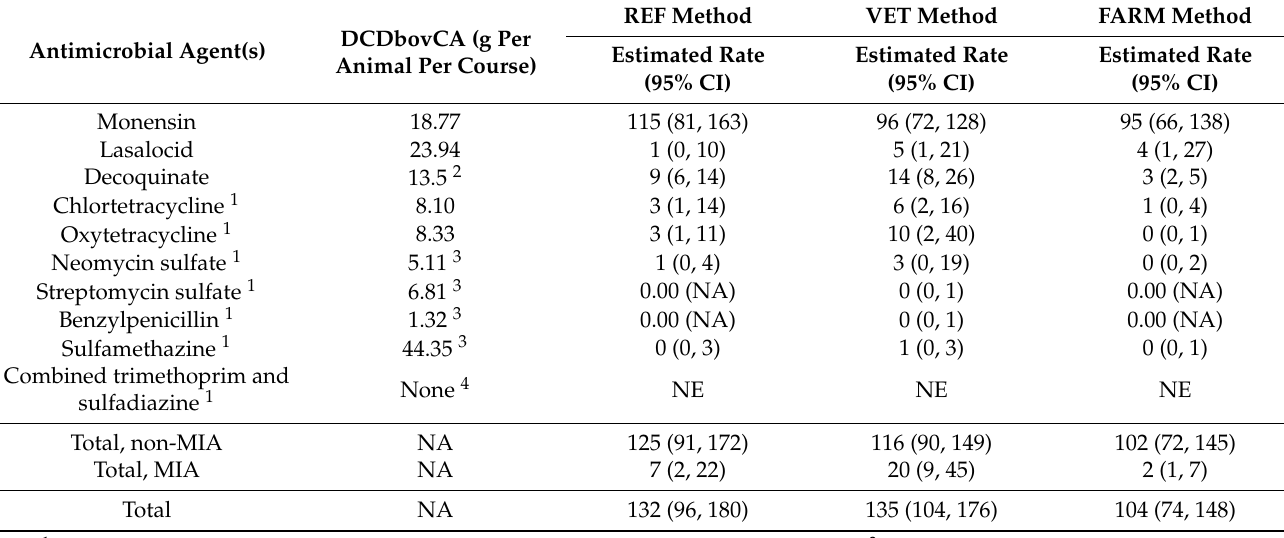
Table A1. Estimates of usage rate in DCDbovCA per 100 cow-years (with 95% CI) by antimicrobial, category (medically important antimicrobials, MIA, or non-MIA), and totally, estimated using negative binomial regression models applied to three quantification methods in 101 dairy farms from Qu é bec, Canada: invoices from feed mills (REF method), veterinary prescriptions (VET method), and in-person interviews of dairy producers (FARM method).